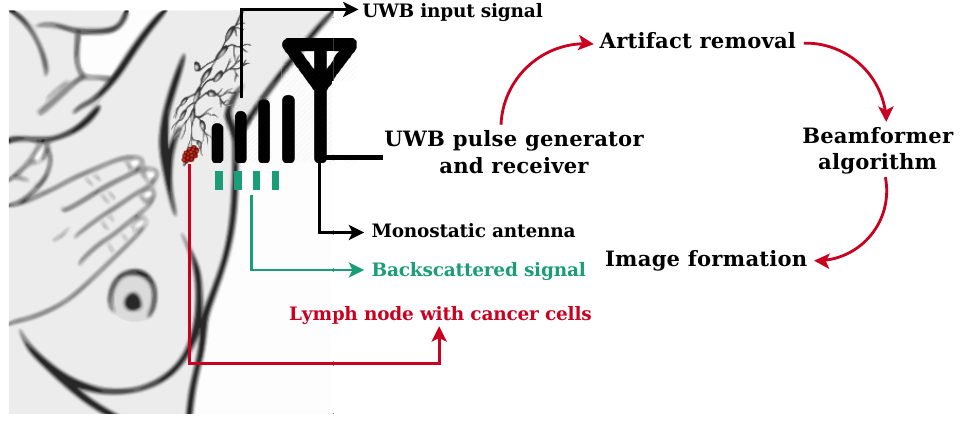
Figure 1. Diagram illustrating the proposed UWB Microwave Imaging radar system for the